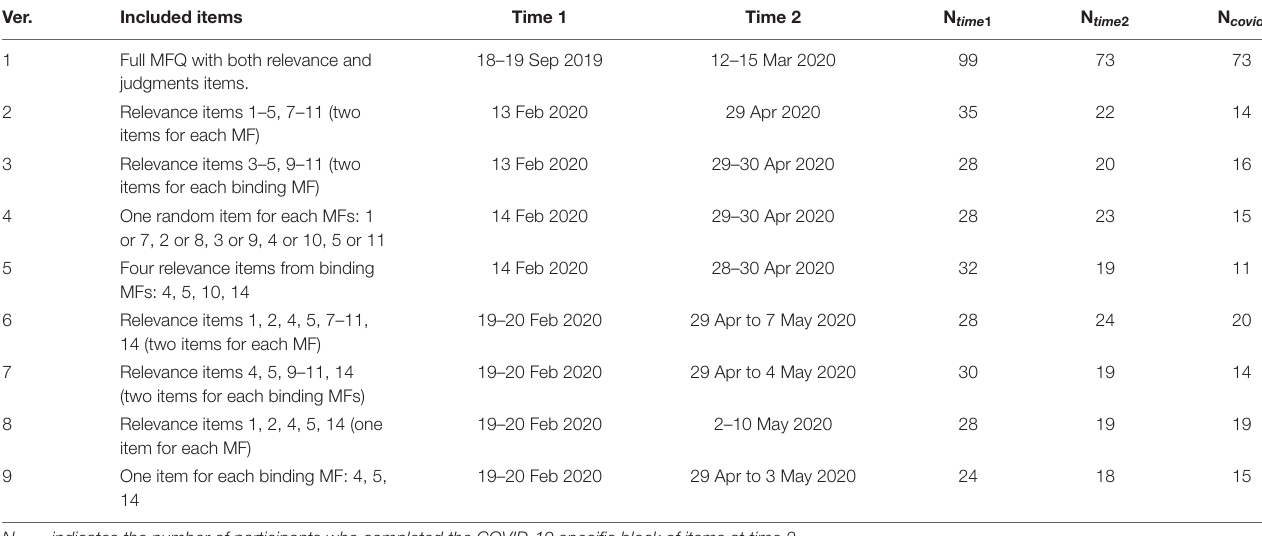
TABLE 1 | Different versions of the MFQ questionnaire included in the study. Ver.